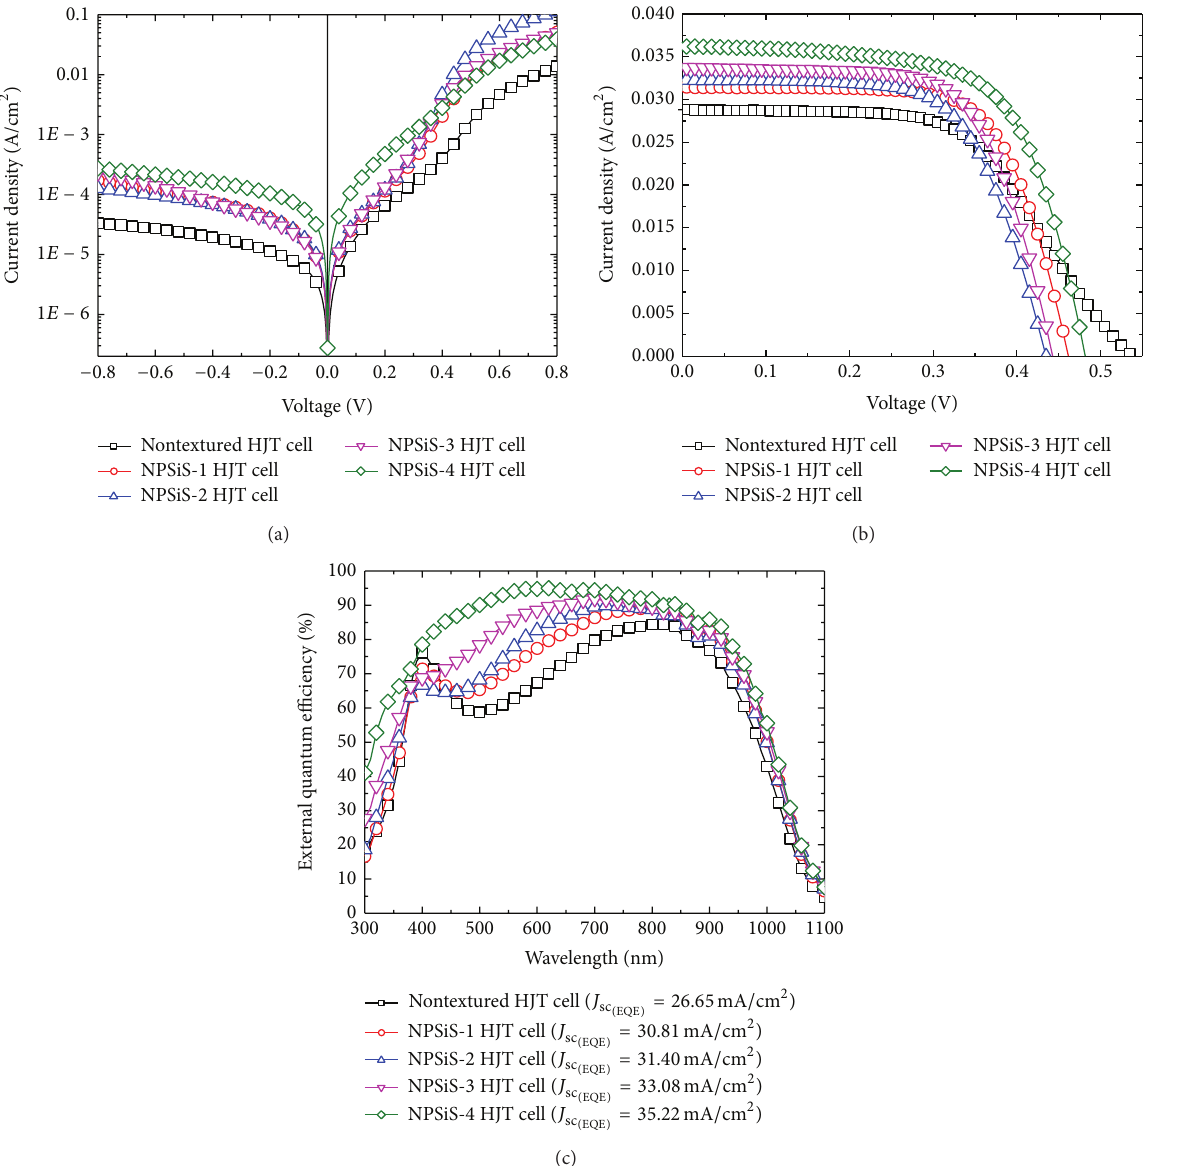
Figure 7: Measured I - V curves of four NPSiS-HJT cells and nontextured HJT cell: (a) dark I - V , (b) illuminated I - V (AM 1.5G condition), and (c) corresponding external quantum efficiency (EQE)